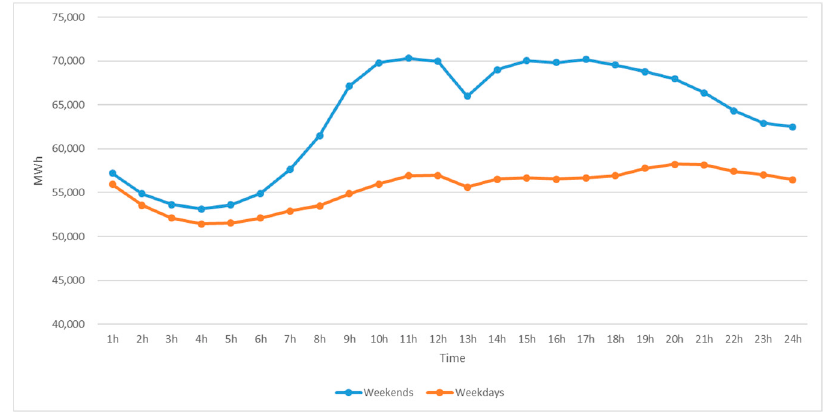
Figure 4. Hourly load profiles of weekday and weekend power usage.